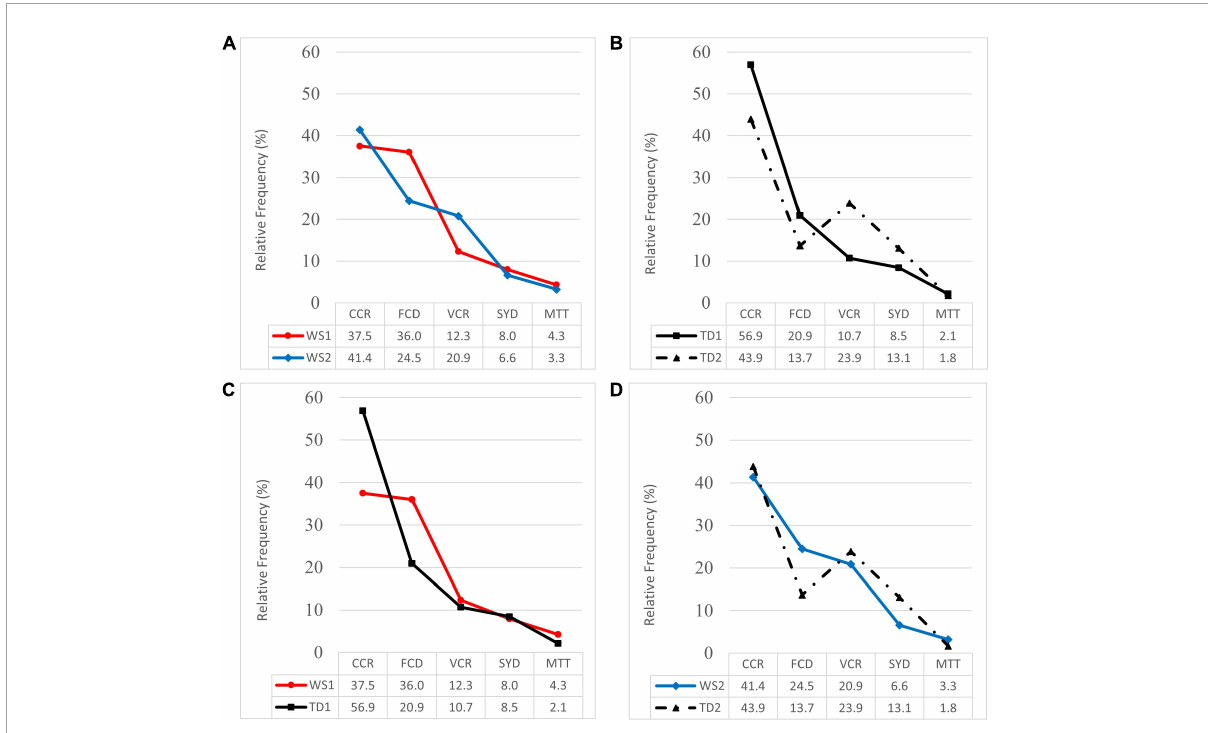
FIGURE2 Profiles of relative frequency of syllable structure processes (CCR, consonant cluster reduction; FCD, final consonant deletion; VCR, vowel cluster reduction; SYD, unstressed syllable deletion; MTT, metathesis) for WS groups and TD groups. (A) Profiles of WS1 and WS2 groups. (B) Profiles of TD1 and TD2 groups. (C) Profiles of WS1 and TD1 groups. (D) Profiles of WS2 and TD2